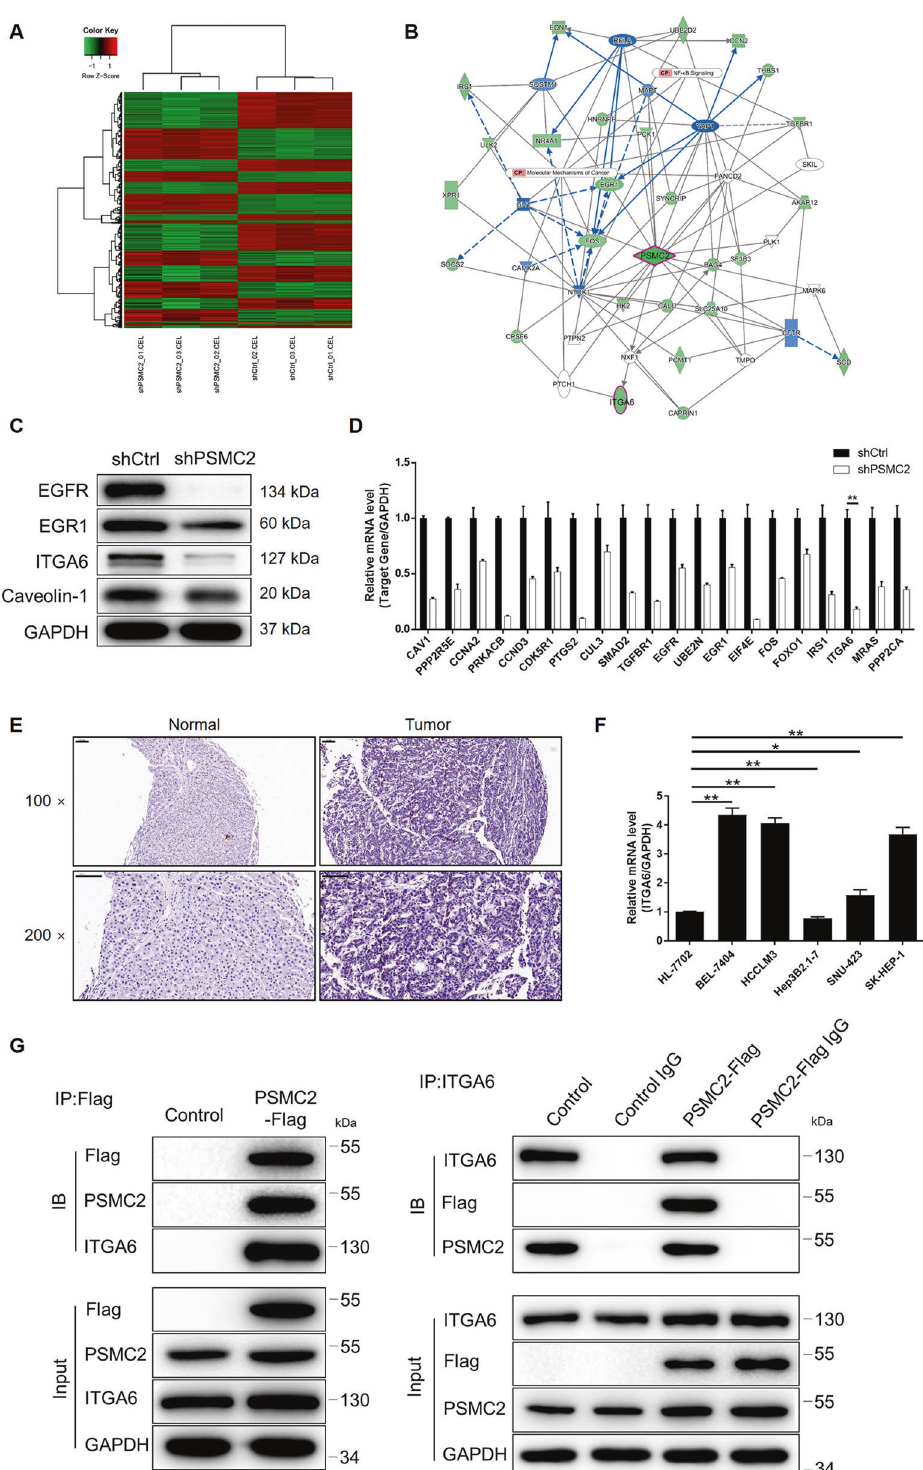
Fig. 3 The exploration and veri fi cation of downstream underlying PSMC2-mediated regulation in HCC. A A PrimeView Human Gene Expression Array was conducted to distinguish the differentially expressed genes (DEGs) of SK-HEP-1 cells with or without silencing PSMC2. B A PSMC2-induced interaction network was established based on IPA analysis. Line: interaction; arrow: regulation; full line: direct regulation; dotted line: indirect regulation; green: downregulation; blue: predicted inhibition; white: with state of downstream molecule. The expression of several selected DEGs in SK-HEP-1 cells with or without PSMC2 knockdown was detected via qPCR ( C ) and western blotting ( D ). E The ITGA6 expression in HCC tissues and normal tissues was evaluated by IHC analysis (scale bar = 100 μ m). F The mRNA expression of PSMC2 in normal cell line HL-7702 and HCC cell lines including HCCLM3, SK-HEP-1, BEL-7404, SNU423, and Hep3B2.1-7 was detected by qPCR. G A co-IP assay was performed to show the direct interaction between PSMC2 and ITGA6. The representative images were selected from at least three independent experiments. Data were shown as mean ± SD. * P < 0.05, ** P < 0.01. Cell Death Discovery (2021)